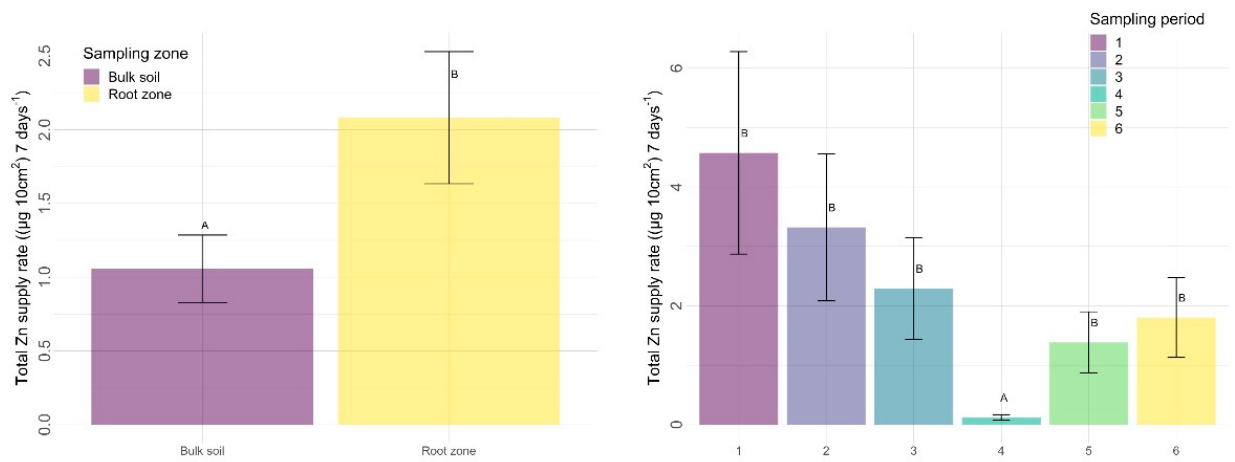
Figure 15. Zn supply rates as a function of sampling zone ( left ) and interaction between sampling zone and time ( right ). Different letters indicate significance at p < 0.05 using the post hoc Tukey HSD test.